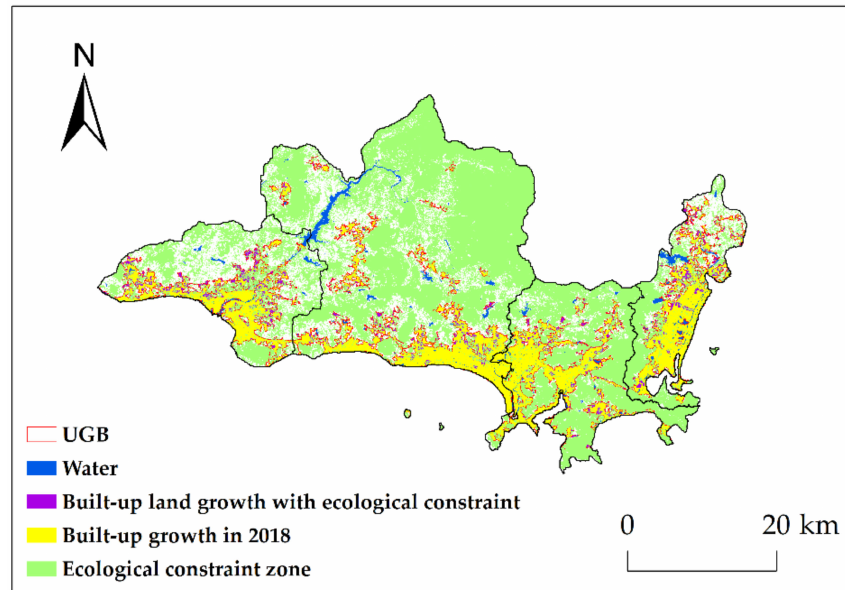
Figure 4. Urban built-up growth simulation and UGB delineation in